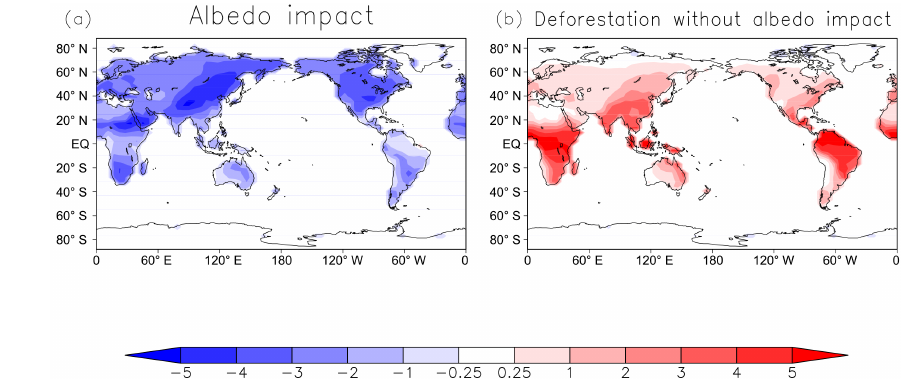
Figure 7. Panel (a) : impact of albedo (only) on temperature change; panel (b) : temperature change without albedo impact (K).